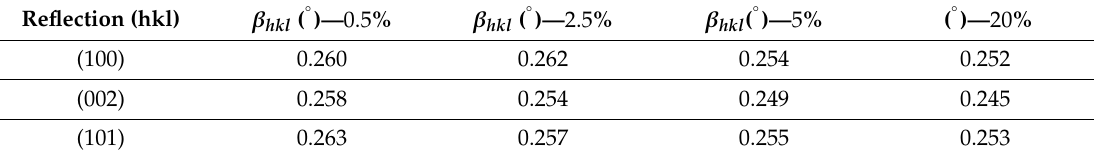
Table 4. The FWHM of the di ff raction peaks on (100), (002) and (101) at 0.5%, 2.5%, 5% and 20% concentration of ZnO